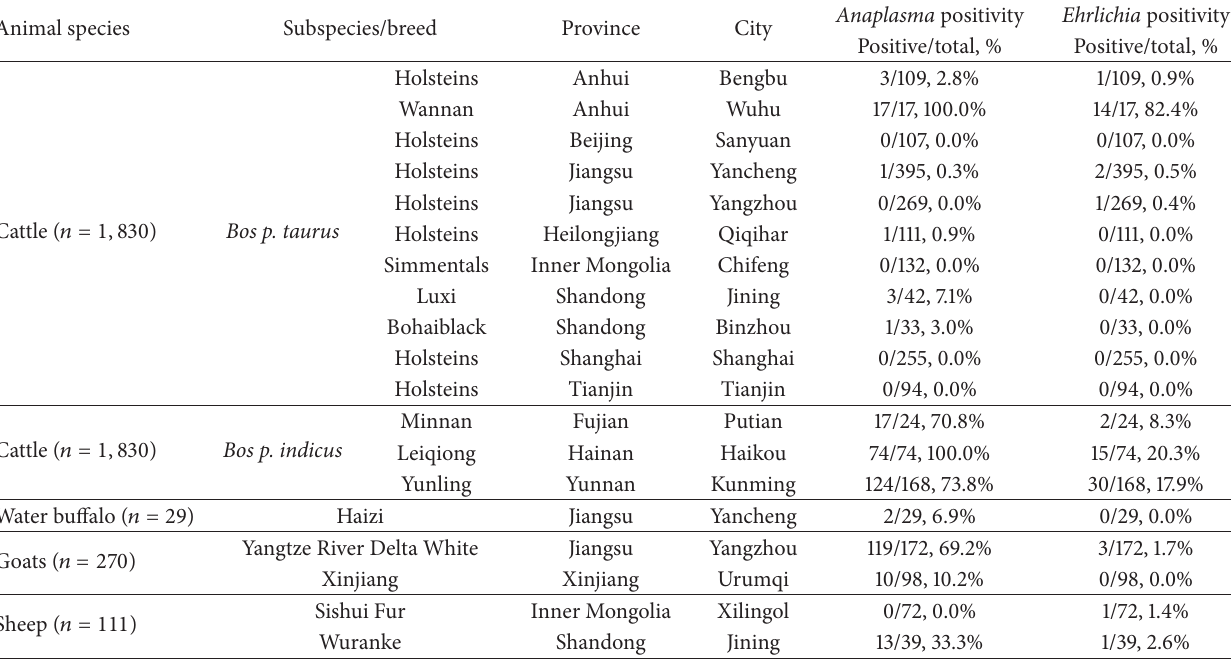
Table 1: Molecular detection of Anaplasma spp. and Ehrlichia spp. in Chinese ruminants.